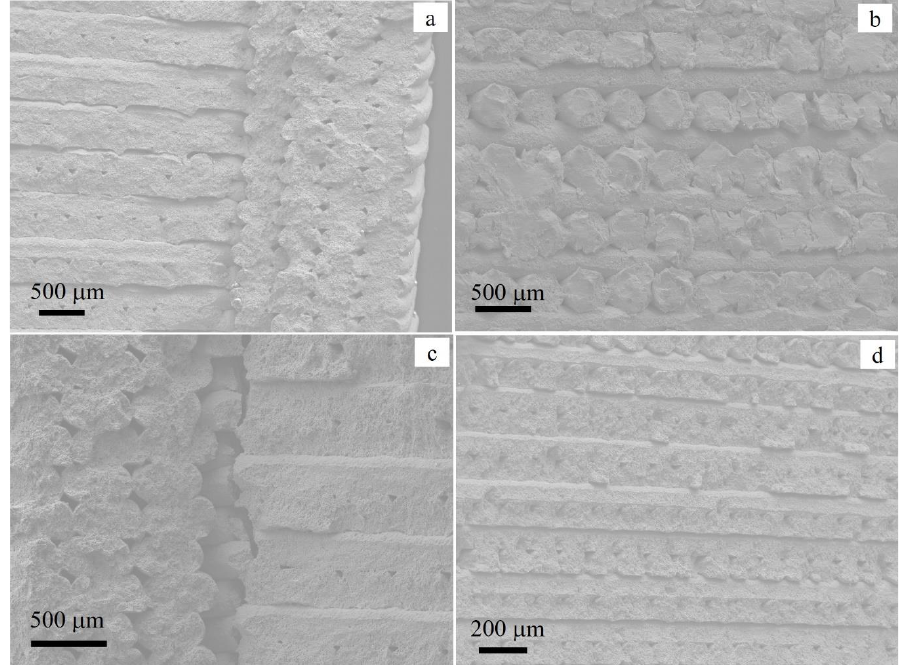
Figure 16. SEM images of the tensile fracture surface with different filament orientations: ( a ) infill on the left and wall on the right/edge, ( b ) alternating filaments in the infill, ( c ) image showing cracks at the interface of infill and wall, and ( d ) filaments oriented in the same direction.